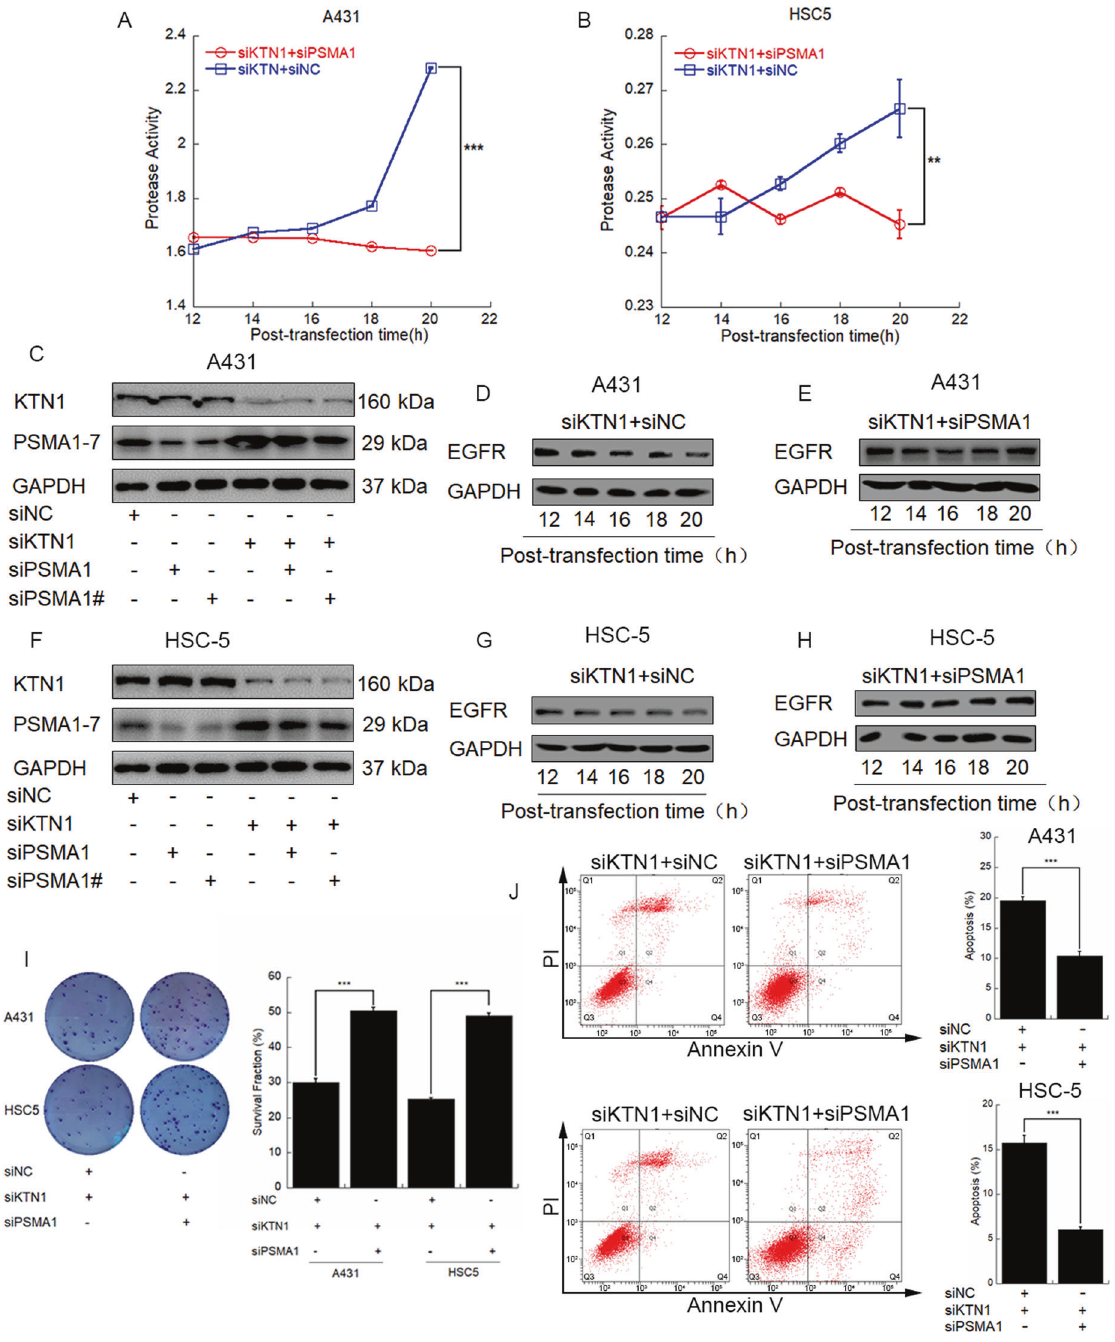
Fig. 4 PSMA1 represents a key modulator in KTN1-mediated EGFR degradation. A , B A431 or HSC-5 cells were transfected with siKTN1 and then harvested to detect protease activity at the indicated times. Data represent the means ± SD. Representative of results from three biological replicates. C A431 cells were transfected with siKTN1 and/or siPSMA1/siPSMA1#. Total cell lysates were subjected to immunoblotting with anti-PSMA1-7 and anti-KTN1. Representative of results from three biological replicates. D , E A431 cells were transfected with siKTN1 or co-transfected with siKTN1 and siPSMA1. Total cell lysates were collected after transfection for the indicated time periods and analyzed by immunoblotting with anti-EGFR. Representative of results from three biological replicates. F HSC-5 cells were transfected with siKTN1 and/or siPSMA1/siPSMA1#, and total cell lysates were subjected to immunoblotting with anti-PSMA1 and anti-KTN1. Representative of results from three biological replicates. G , H HSC-5 cells were transfected with siKTN1 or co-transfected with siKTN1 and siPSMA1. Total cell lysates were collected at the indicated times and analyzed by immunoblotting with anti-EGFR. Representative of results from three biological replicates. I A431 or HSC-5 cells were transfected with siKTN1 or co-transfected with siKTN1 and siPSMA1. Total cell lysates were collected for colony formation assay. Survival fractions represent the means ± SD. Representative of results from three biological replicates. J A431 or HSC-5 cells were transfected with siKTN1 or co-transfected with siKTN1 and siPSMA1. Total cell lysates were collected for fl ow cytometry analysis of apoptotic cells. Apoptotic cell ratios represent the means ± SD. Representative of results from three biological replicates.